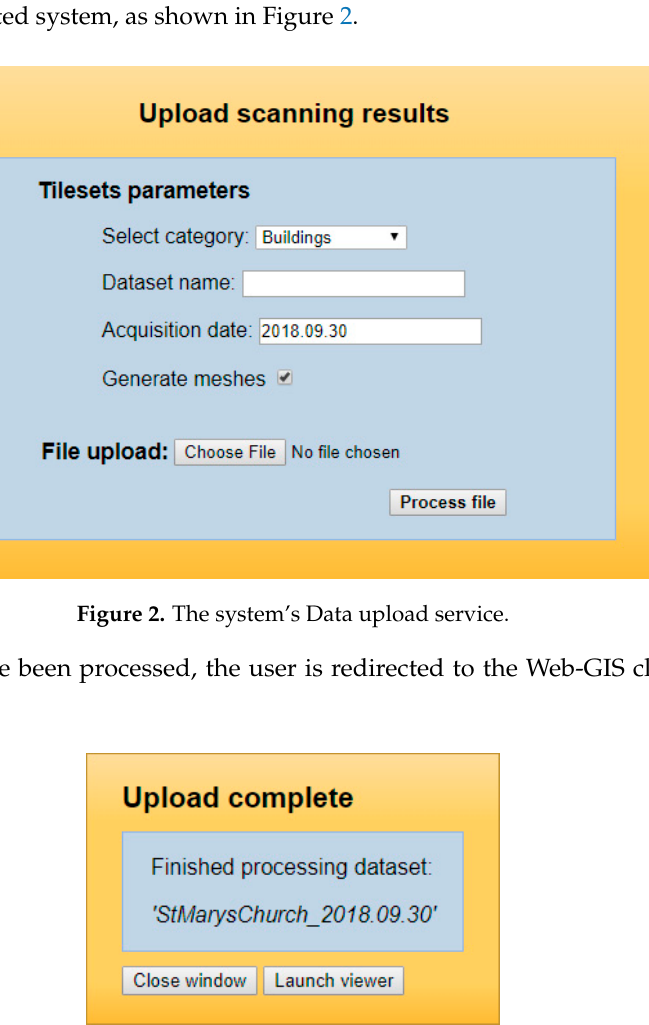
Figure 3. When data processing completes, the Data upload module redirects the user to the Web-.